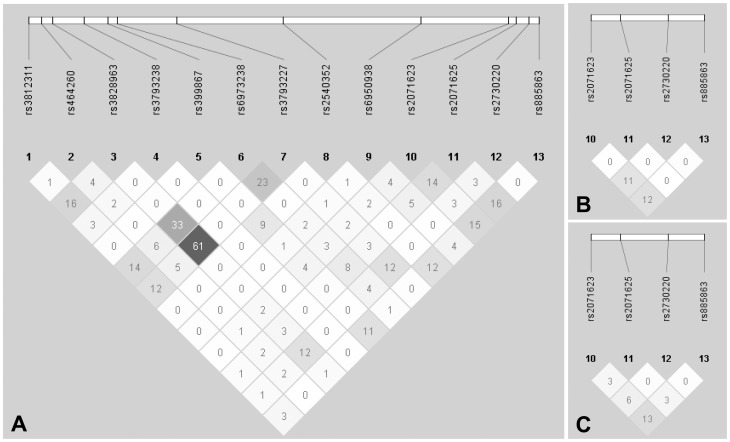
Linkage disequilibrium (LD) patterns for single nucleotide polymorphisms of the VIPR2 gene.LD measures are indicated as r2 values for cases and controls together for (a) the discovery sample set, (B) the replication sample, and (C) the combined sample set. Note that, as defined by solid spine of LD, no LD bock is identified in any of the sample sets.